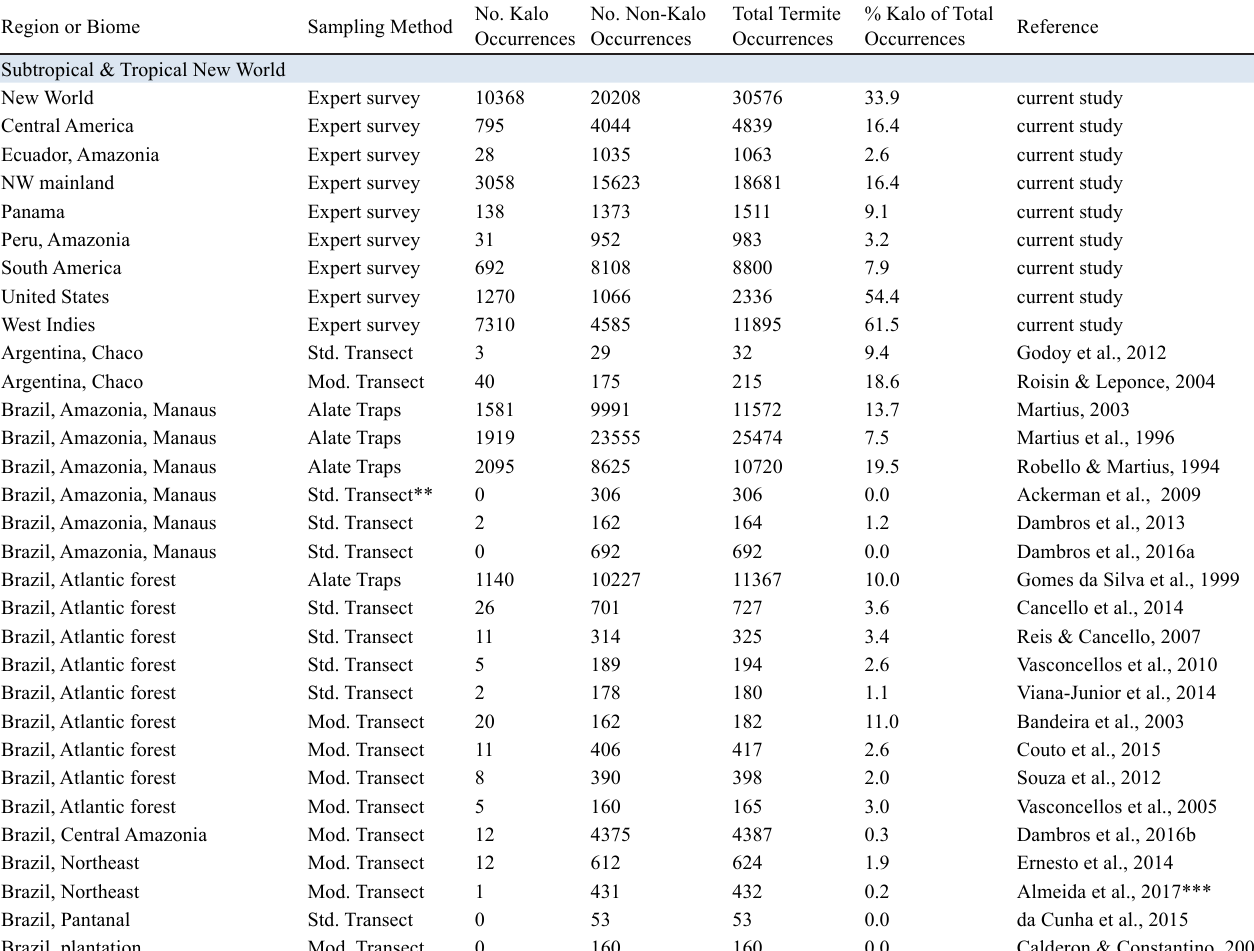
Table 1 . Studies listing occurrences of kalotermitid and non-kalotermitid termites in wooded habitats by sampling method. Region or